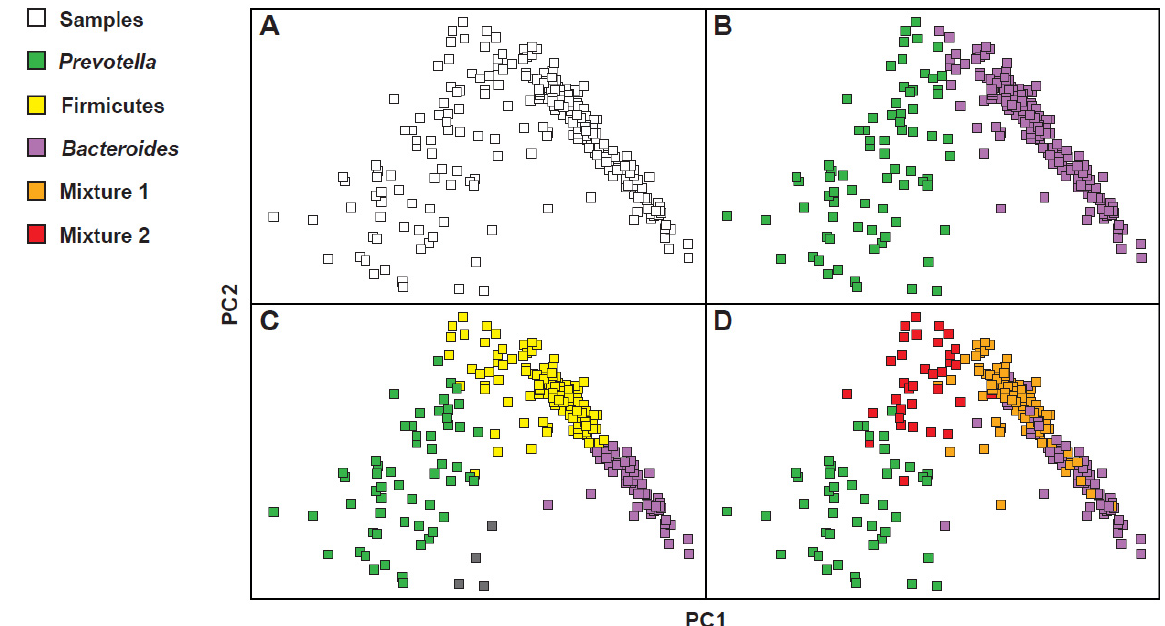
Figure 2. Re-analysis of three different large fecal metagenomic datasets. Although the emergence of community profiles is modest, in certain areas of the graphs obtained by analysing the principal coordinates (PC1 and PC2), certain densities of samples appear. The use of colors makes these densifications more evident. ( A ) gradient-model; ( B ) 2-cluster model; ( C ) 3-cluster model; ( D ) 4-cluster model. Modified from: [19].